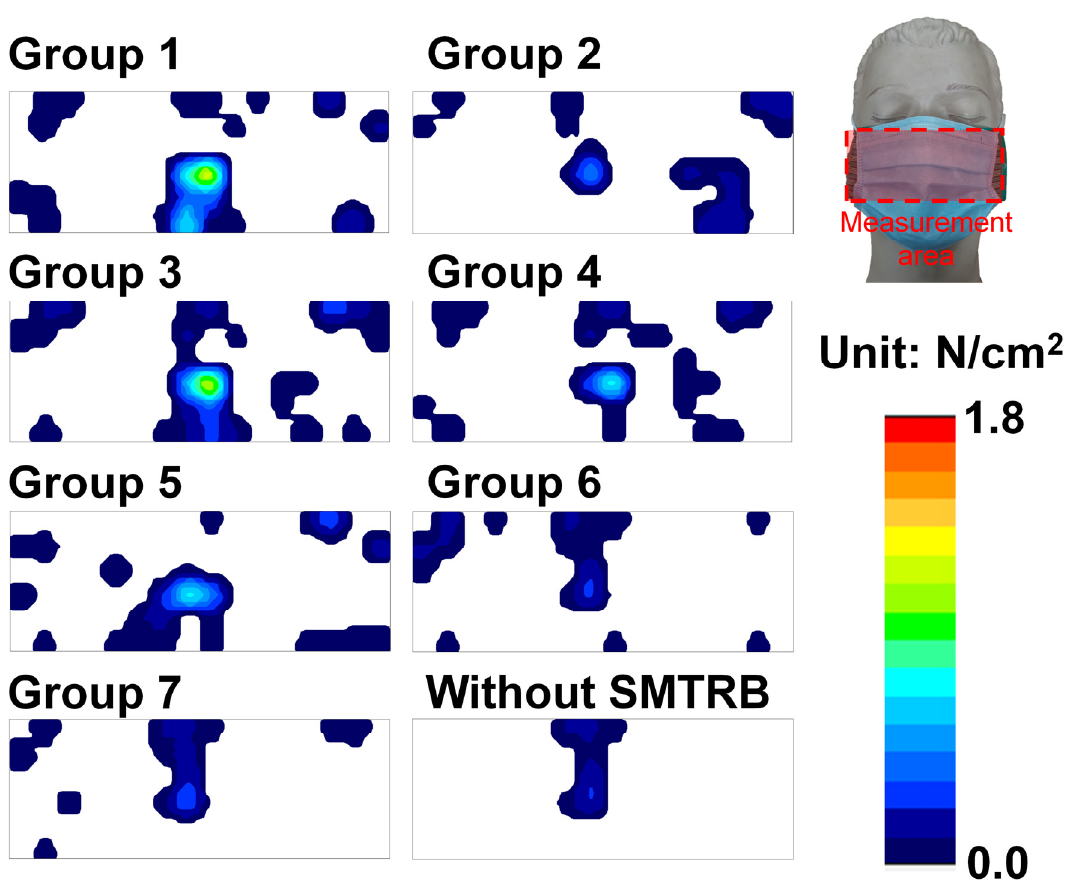
Figure 6. The pressure distribution on the dummy head when a mask was used with an SMTRB.